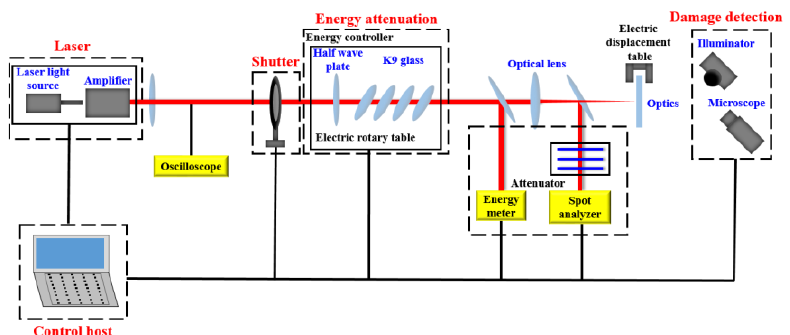
Figure 3. Laser damage test diagram.